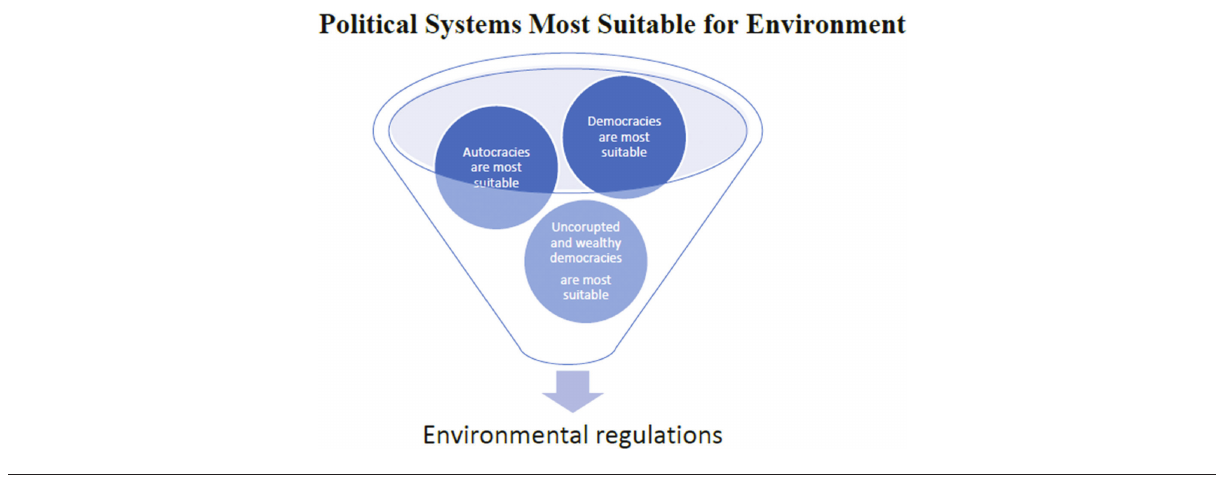
Figure 4. Role of political systems in creation of policies, laws and regulations to protect the environment and respond to disasters (Source: Author,